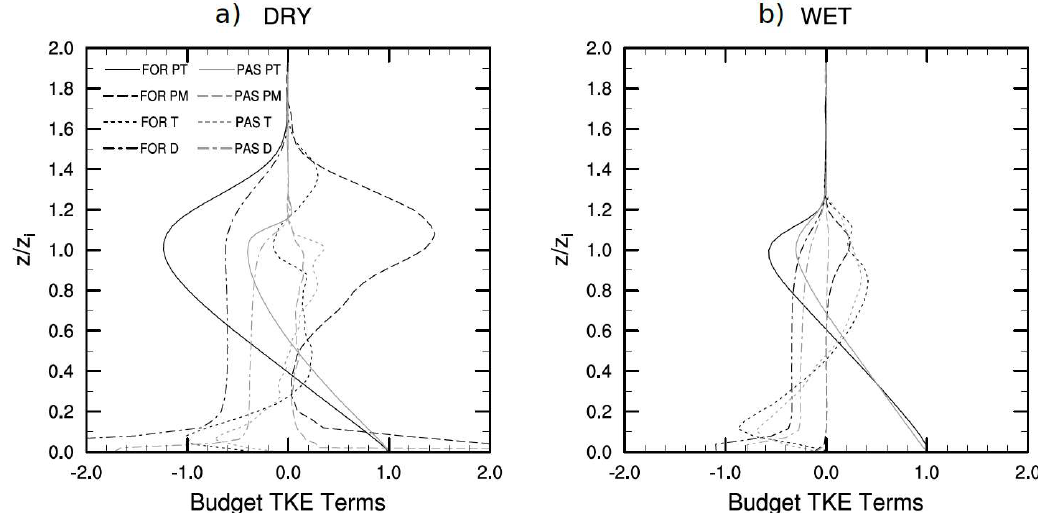
Figure 7. Budget of turbulent kinetic energy (normalized by w*/Zi) over FOR (dark grey) and PAS (light grey) surfaces in DRY and WET.